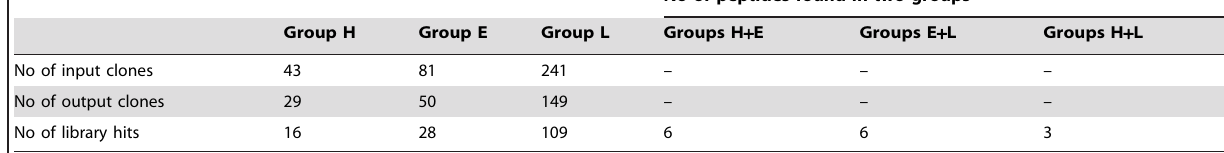
Table 1. Summary of 454 high-throughput sequencing data